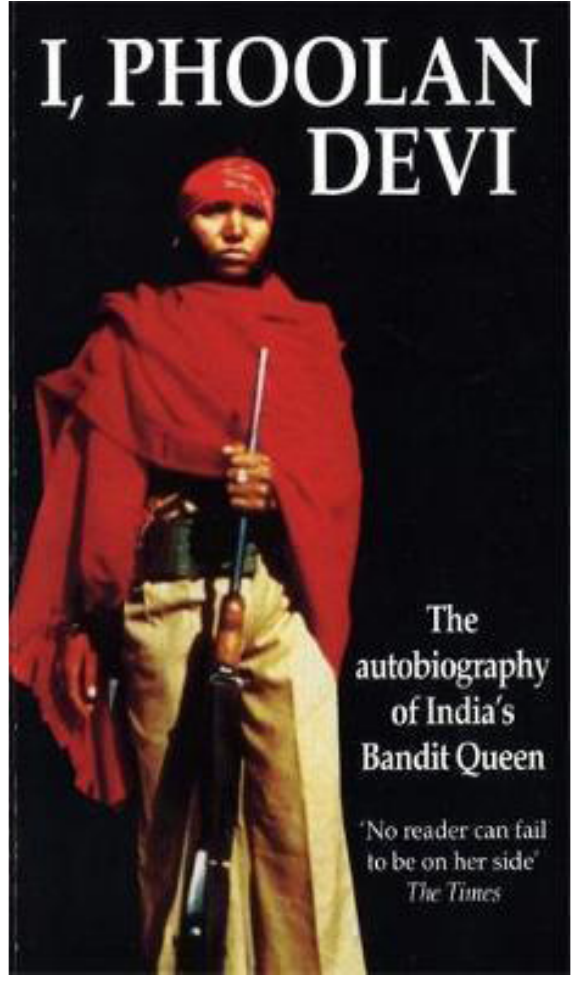
Figure 3: Bandit